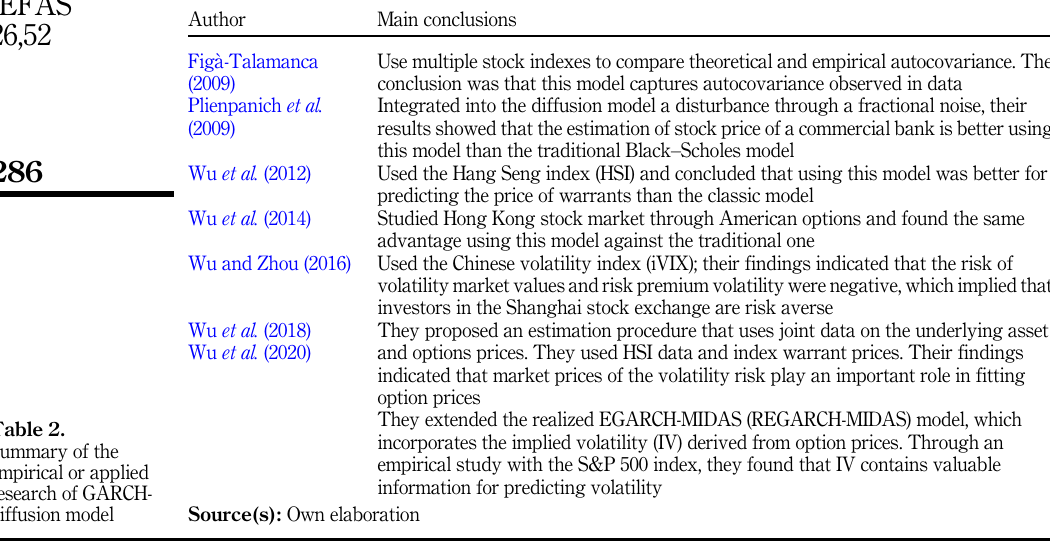
Table 2. Summary of the empirical or applied research of